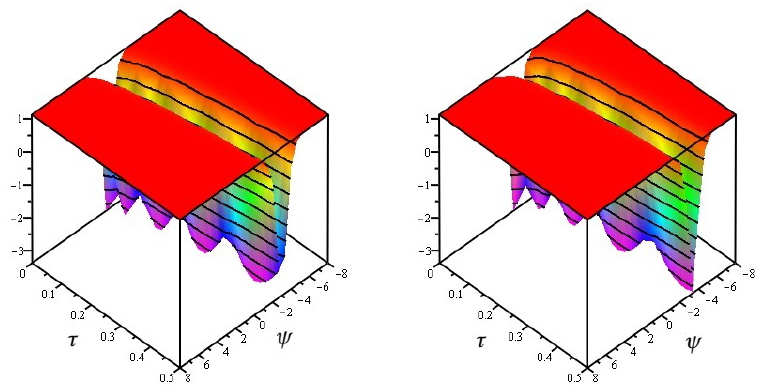
Figure 2. The analytical solutions of ν ( ψ , τ ) at (cid:118) = 0.6 and 0.4.